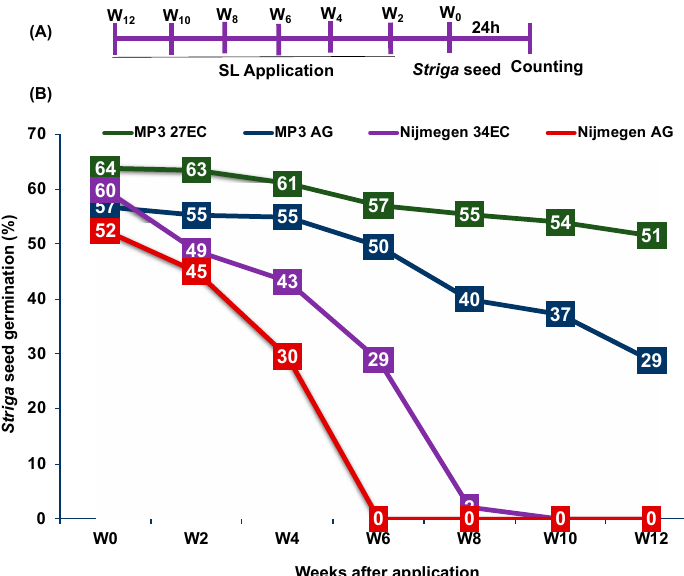
Figure 4. Stability of EC and AG formulation of the two strigolactone analogs. ( A ) Scheme of the experiment conducted biweekly to test the stability of SL analogs. ( B ) Striga seeds germination in response to two formulations of MP3 and Nijmegen at two-week intervals. Each SL analog (10 mL) was applied in a Petri plate on 5 filter papers and incubated at 30 °C for two-week intervals up to 12 weeks. The Striga seeds collected from a sorghum field in Sudan were evaluated for germination in each Petri plate. Data are means ± SE ( n = 5).